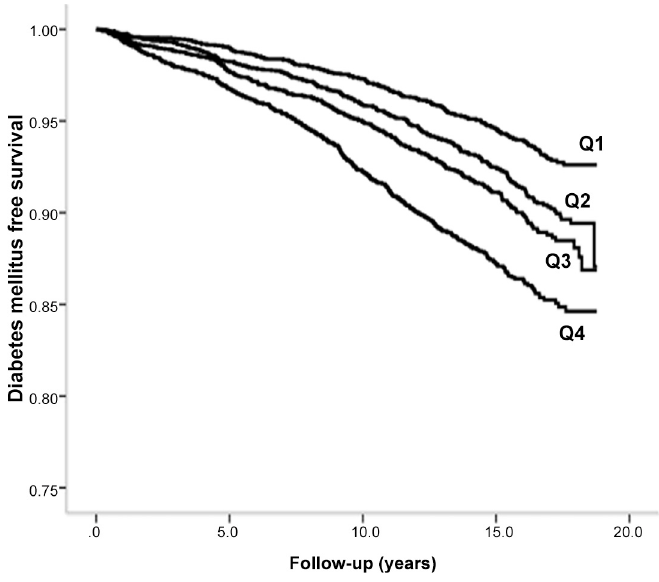
Fig 3. Diabetes mellitus free survival in relation to quartiles of total leukocytes in